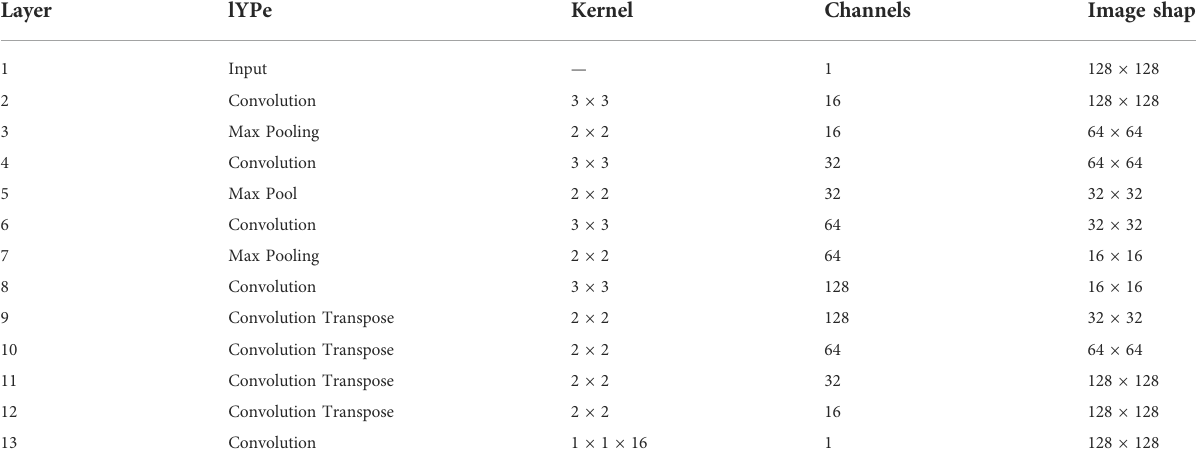
TABLE 1 Network structure of CookieNetAE.[18]. All convolution layers use ReLU activation. Layer